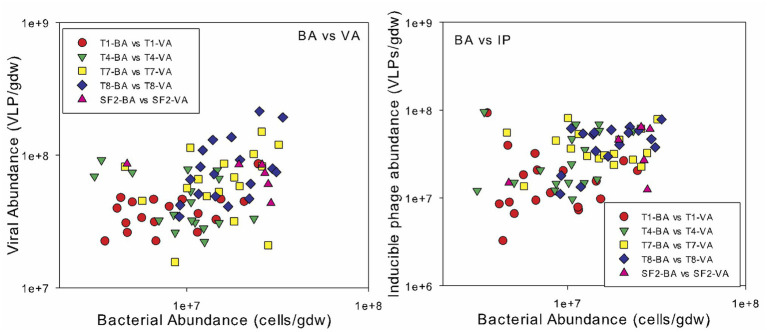
Relationship between bacterial abundance (BA) and viral abundance (VA, left) and inducible phage abundances (IP, right). The land management treatments are the same as described in Figure 1.